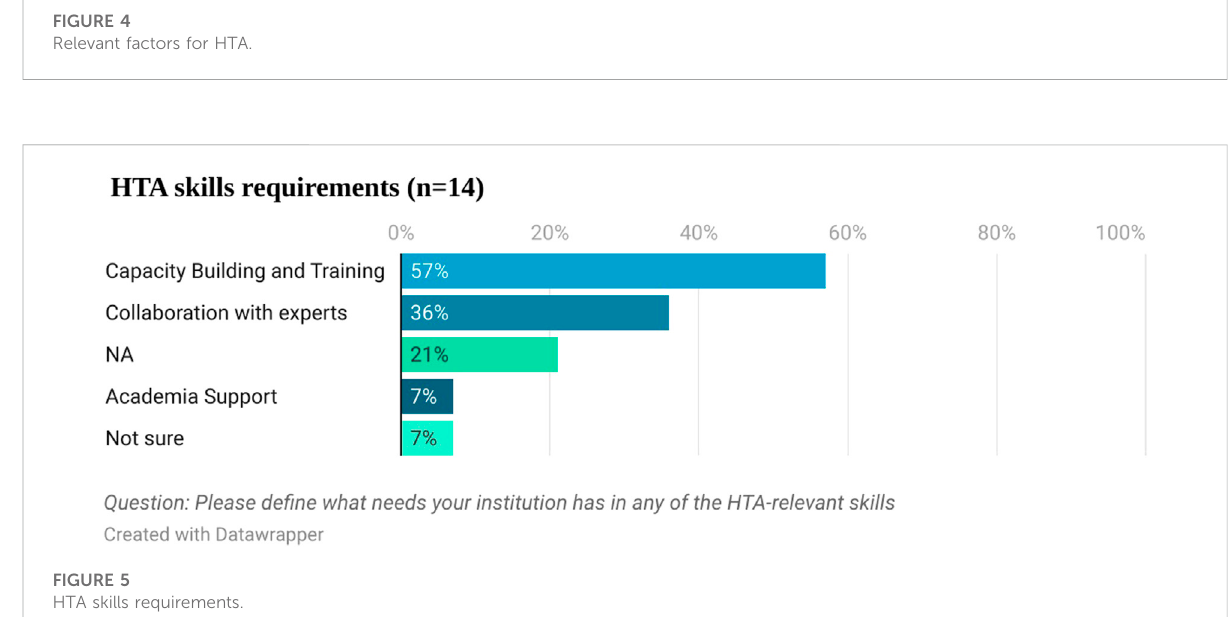
FIGURE 4 Relevant factors for